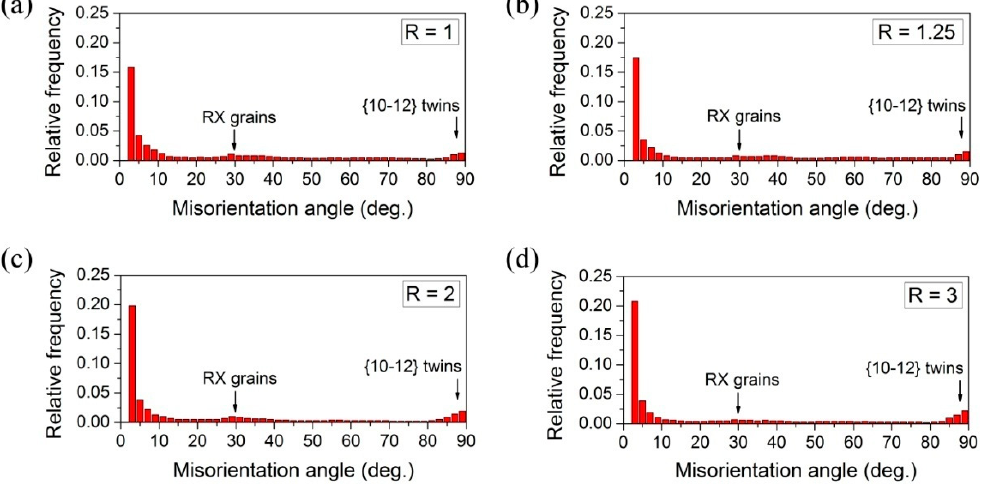
Figure 2. The misorientation angle distributions of the as-rolled Mg-6Sn sheets processed at speed ratio of: ( a ) R = 1, ( b ) R = 1.25, ( c ) R = 2 and ( d ) R = 3.